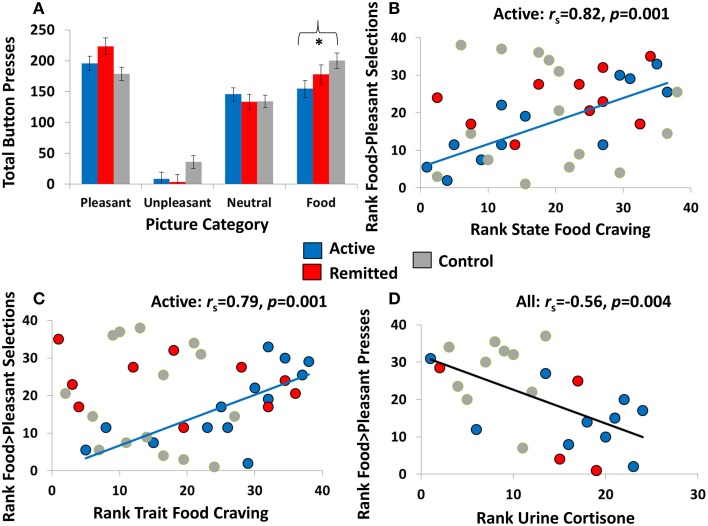
Relevant choice task results and scatterplots showing associations between food-related choice with state food craving and cortisol. (A) Results of the explicit task showing total button presses (estimated marginal means) for each of the four picture categories (pleasant, unpleasant, neutral, and food) for individuals with active Cushing's syndrome (N = 13), individuals with Cushing's syndrome in remission (N = 10), and overweight comparison participants (N = 15). The asterisk indicates a significant linear contrast among the groups at p < 0.05, and error bars represent standard error of the mean. Note that results of the probabilistic choice are not shown, given the nonsignificant Picture Category × Diagnosis interactions (for descriptive statistics of this task, see Table 2). (B,C) In individuals with active Cushing's syndrome but not the other two study groups, higher probabilistic food choice (compared with probabilistic non-food pleasant choice) correlated with higher state and trait food craving. (D) Across all participants for whom urine cortisol markers were available (N = 24), higher explicit food choice (compared with explicit non-food pleasant choice) correlated with lower urine cortisone.